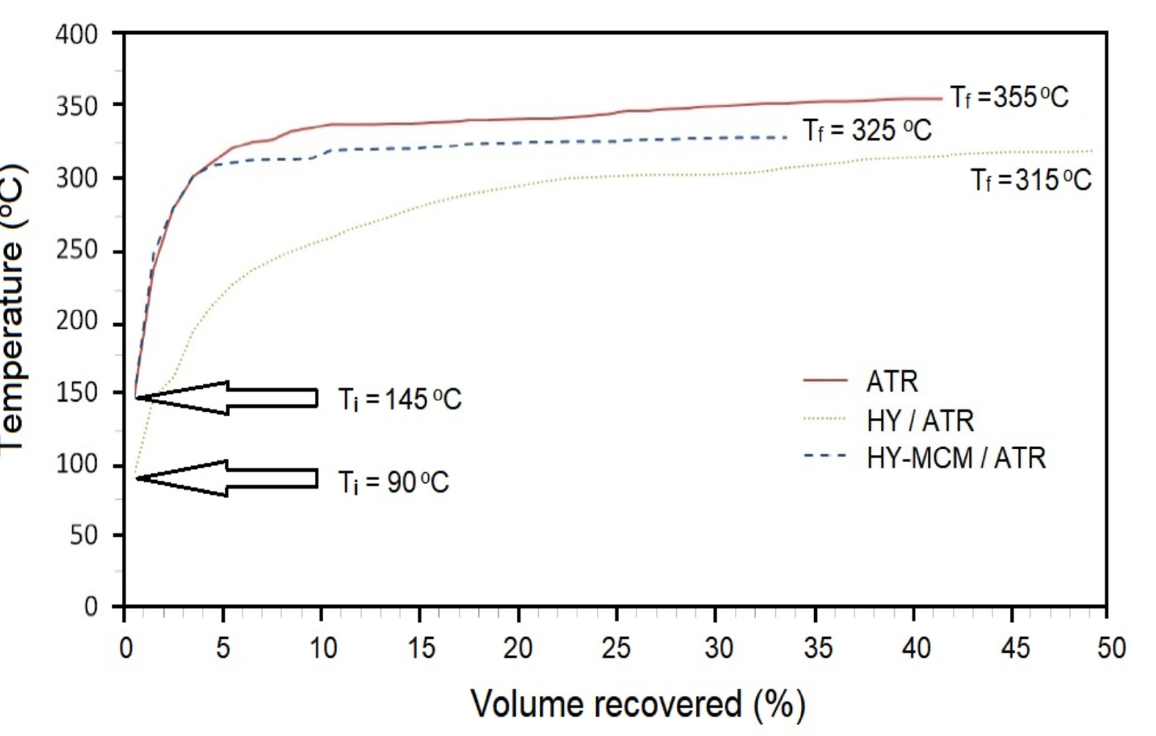
Figure 3. Standard distillation curve, as measured by the ASTM D86 method for ATR, and the catalytic distillation for HY/ATR and HY-MCM-41/ATR.